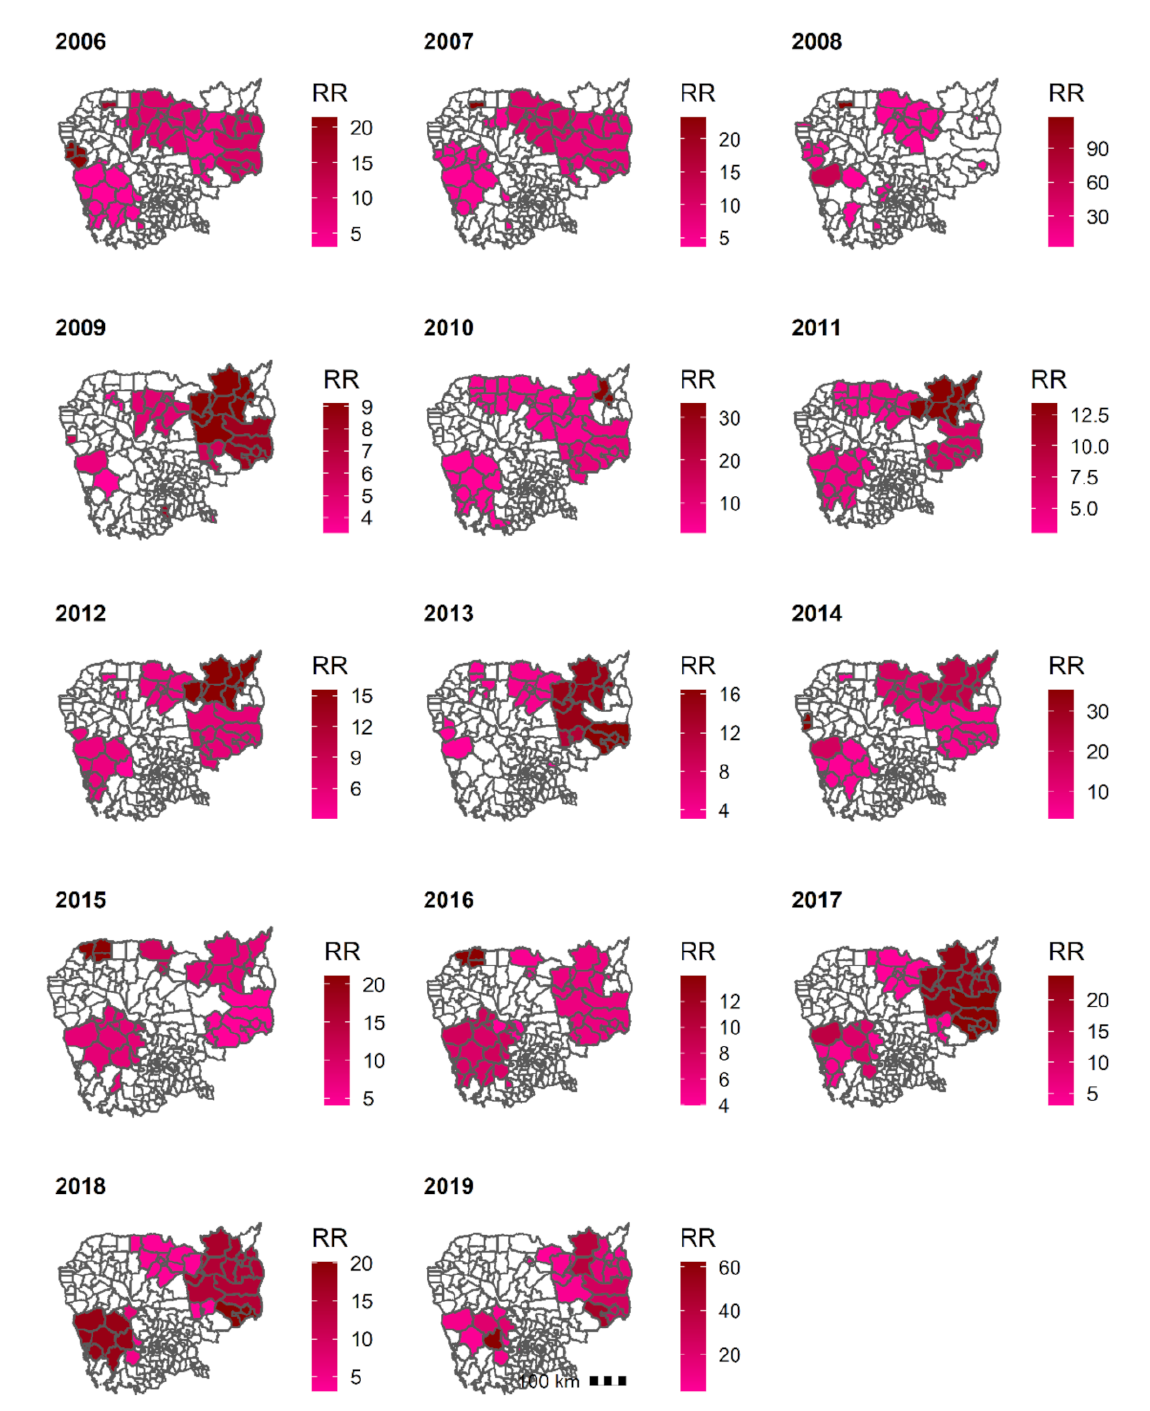
Figure 6. Clusters of confirmed P. falciparum + Mixed cases, 2006–2019, Cambodia. Abbreviation: RR, relative